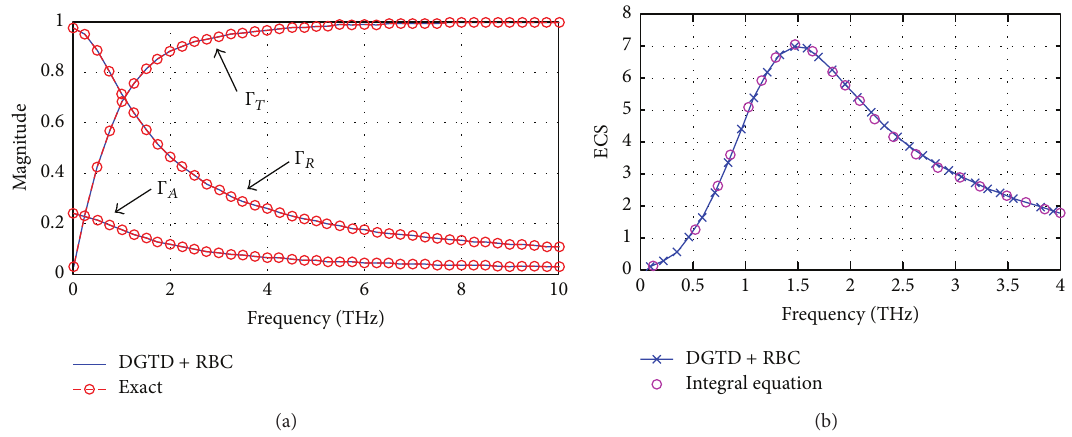
Figure 8: (a) The magnitude of reflection Γ 𝑅 , transmission Γ 𝑇 , and absorption Γ 𝐴 coefficients calculated by DGFD as well as the theoretical value. (b) Normalized extinction cross section of a graphene patch calculated by DGTD and integral equation method